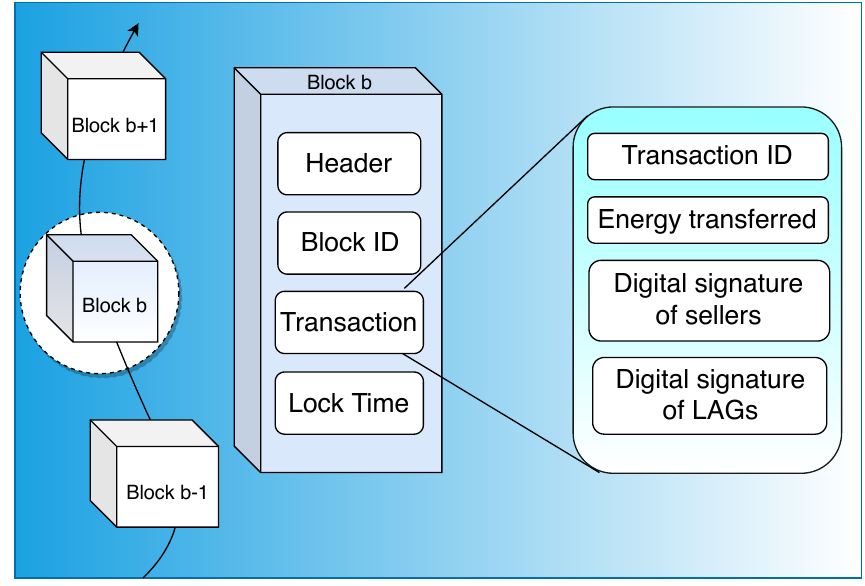
Figure 6. Block structure of energy trading in electric